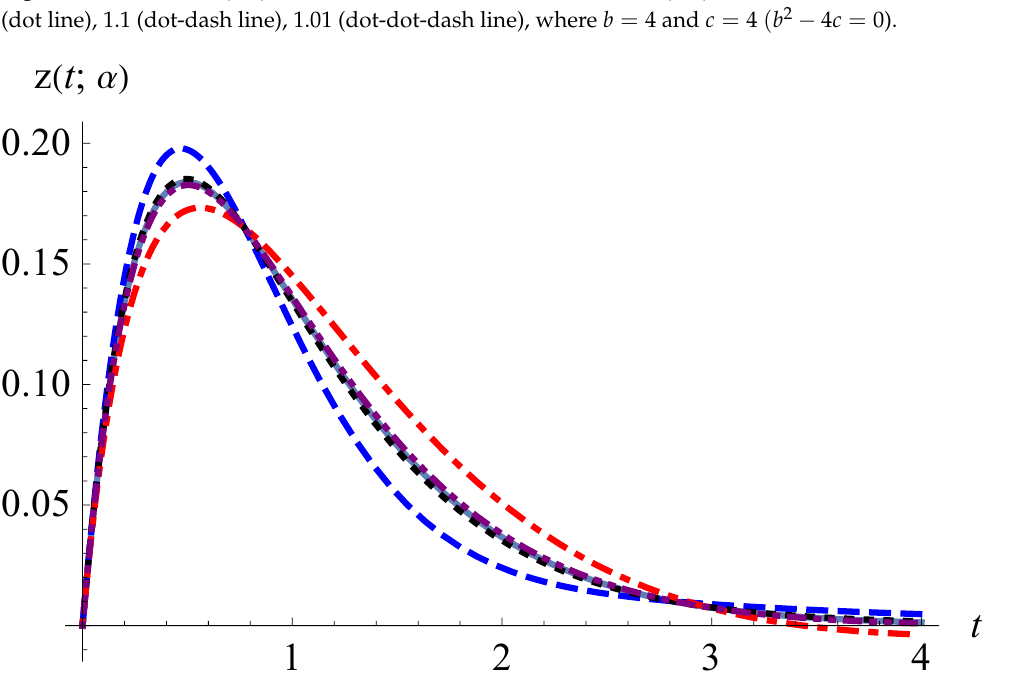
Figure 18. Curves of z ( t ;1 ) (solid line) and residue contribution z ( t ; α ) for α = 0.9 (dash line), 0.99 (dot line), 1.1 (dot-dash line), 1.01 (dot-dot-dash line), where b = 4 and c = 4 ( b 2 − 4 c = 0). Nevertheless, if b 2 − 4 c < 0, then the variations of the residue contribution z R ( t ; α ) and the Hankel integral contribution z H ( t ; α ) are different from the former two situations. From Equations (9), (28) and (50), we derive that z R ( t ; α ) → z ( t ; 1 ) in Equation (14) as α → 1. Moreover, from Figures 19 and 20, we can see that the residue contribution z R ( t ; α ) approaches z ( t ; 1 ) and the Hankel integral contribution z H ( t ; α ) approaches 0 as α →